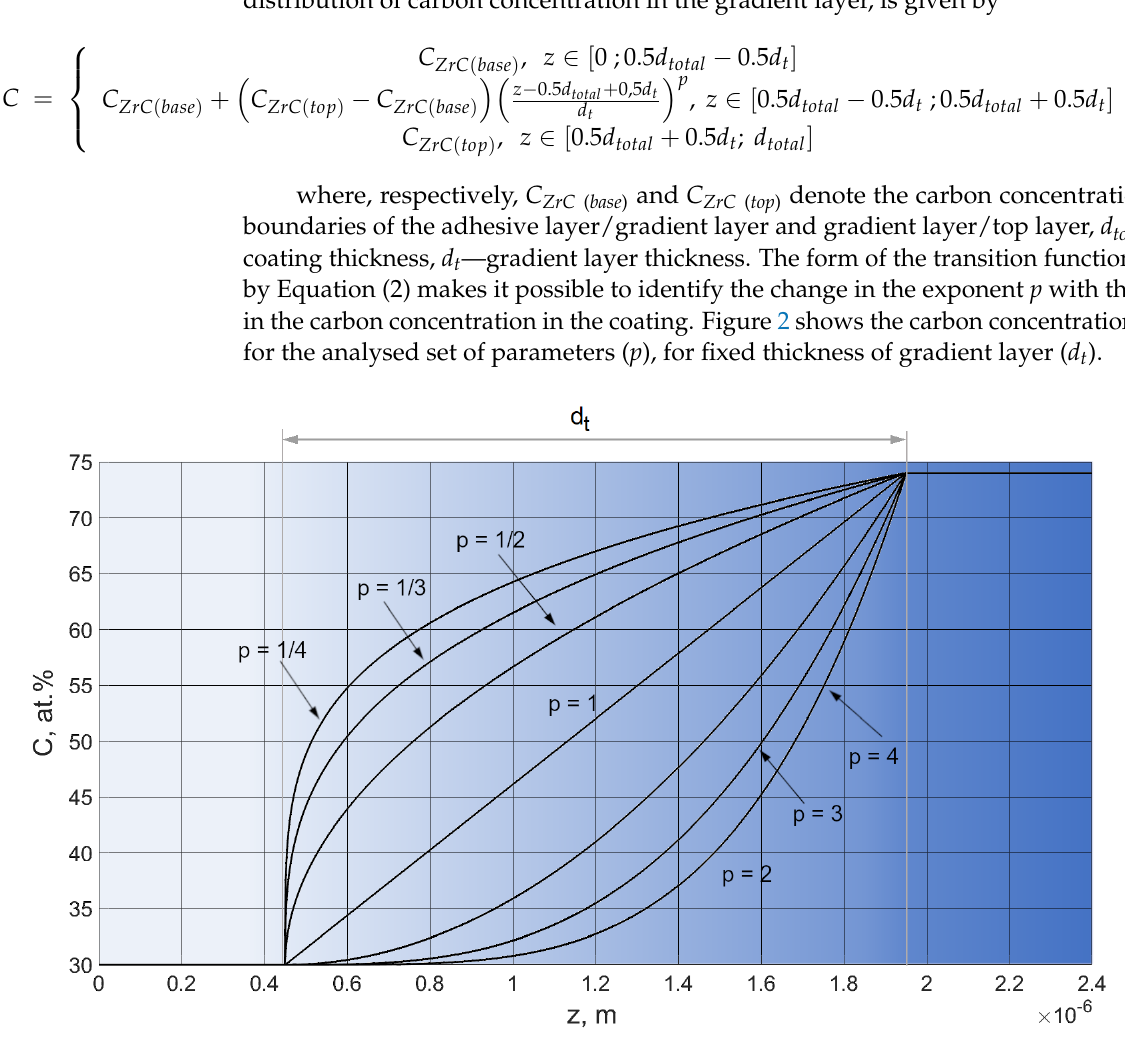
Figure 2. Carbon concentration profiles for analysed set of parameters.